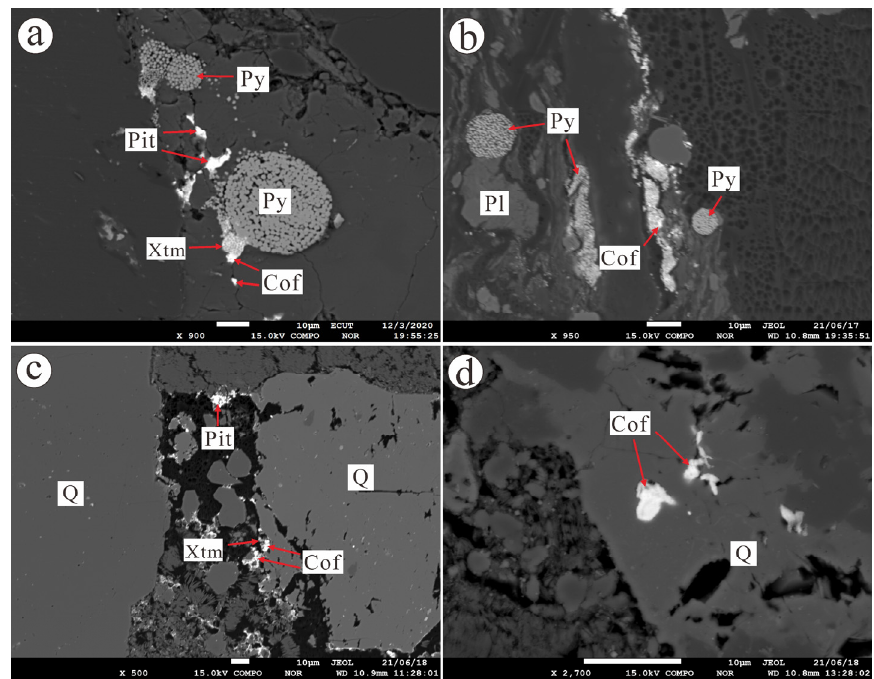
Figure 5. Microscopic characteristics of uranium minerals in the Yuqia uranium occurrences. ( a , b ) Coffinite and pitchblende, distributed in irregular granular and gelatinous forms at the edges of strawberry pyrites and xenotimes, or cemented with strawberry pyrites; ( c ) pitchblende and coffinite distributed in irregular granular and starlike shape at the edge of quartz; ( d ) the coffinite distributed in quartz fissures or corrosion pits in the form of irregular grains. Abbreviations: Q, quartz; Pit, pitchblende; Cof, coffinite; Py, pyrite; Xtm, xenotime.